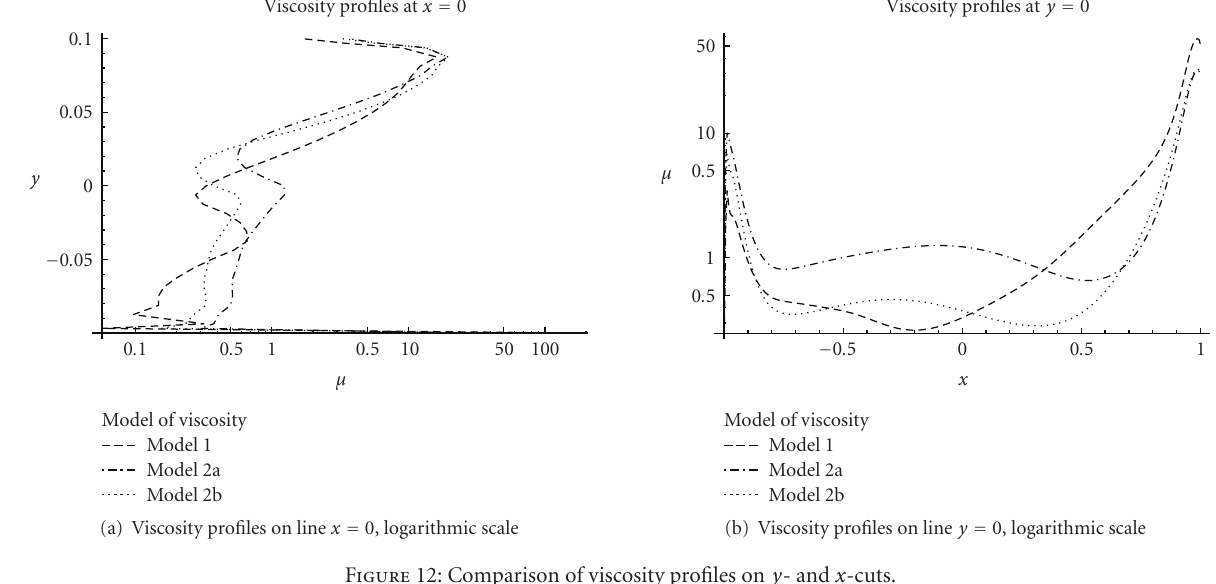
Figure 12: Comparison of viscosity profiles on y - and x -cuts.